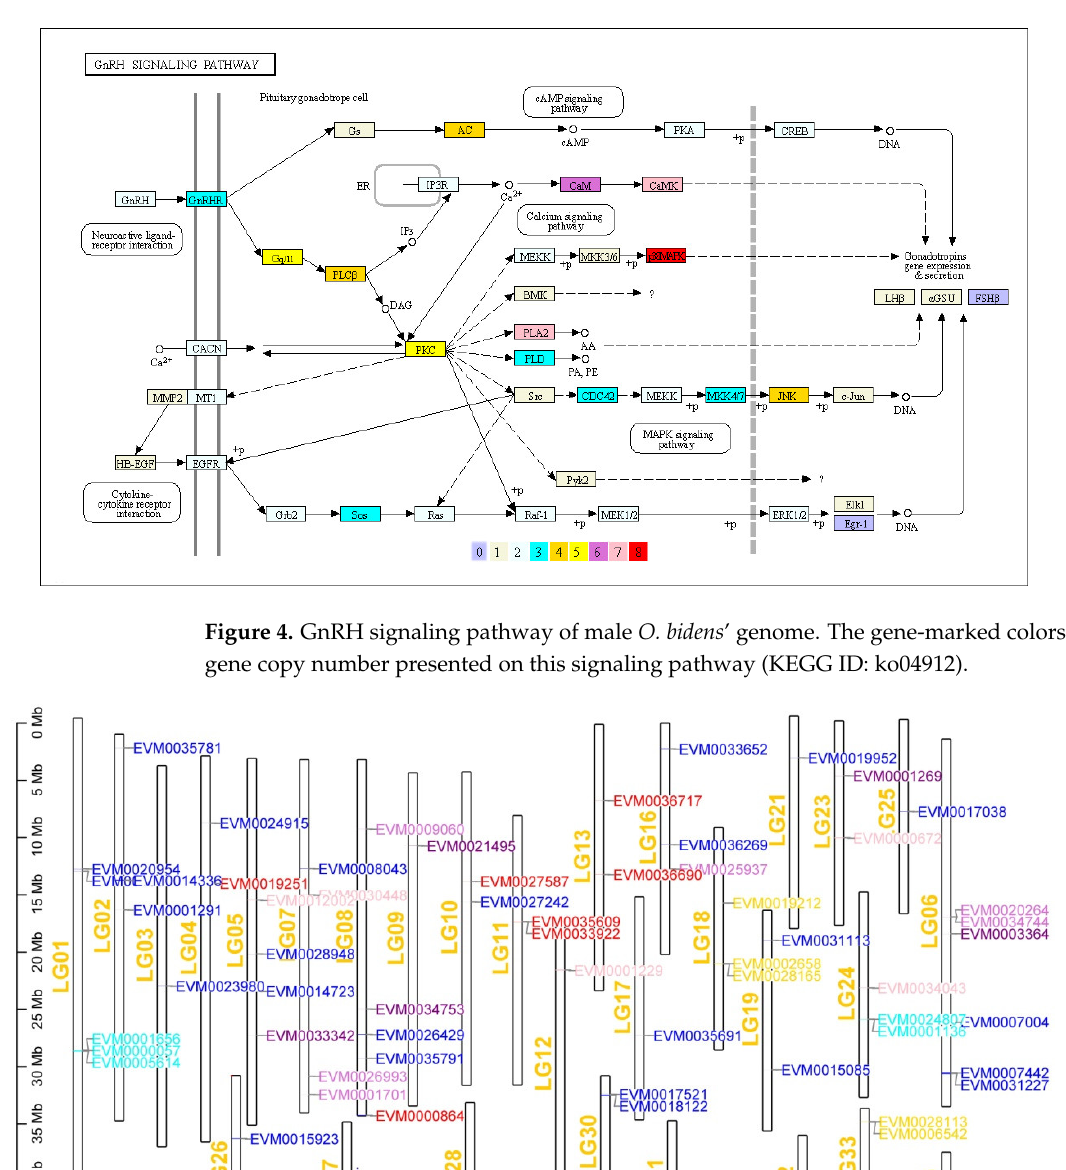
Figure 4. GnRH signaling pathway of male O. bidens ’ genome. The gene-marked colors indicate the gene copy number presented on this signaling pathway (KEGG ID: ko04912).